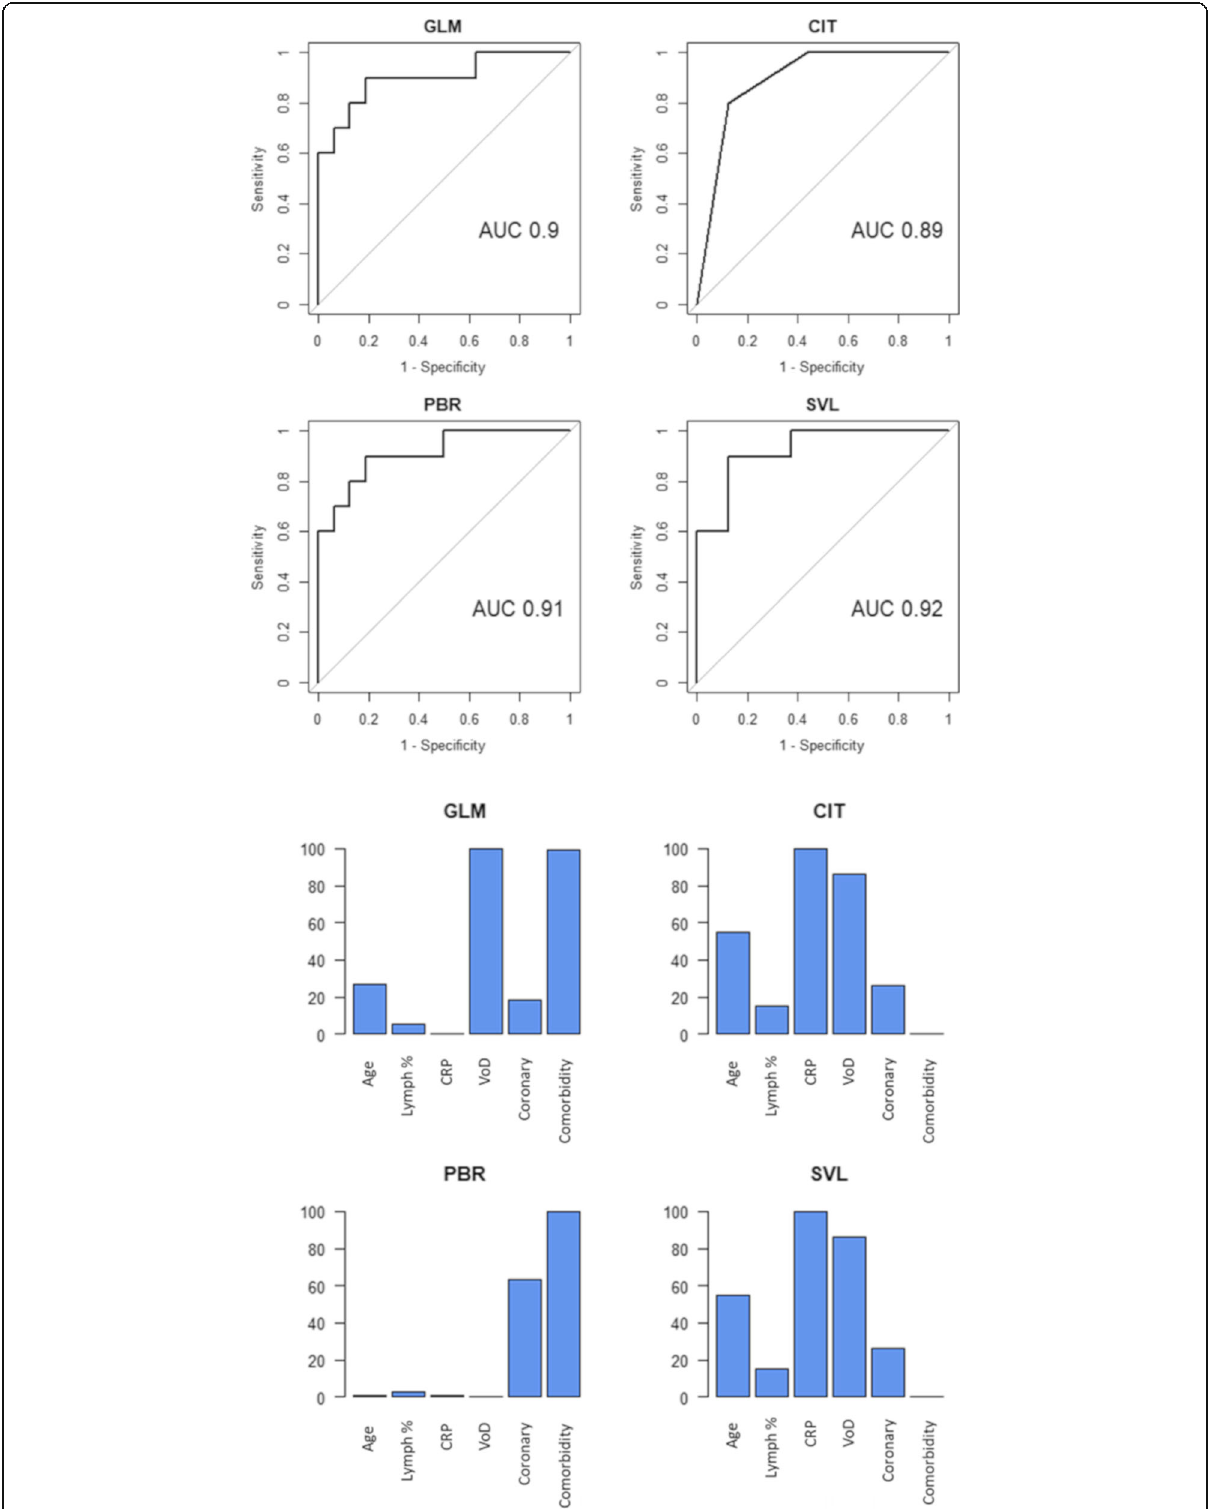
Fig. 5 Shows receiver operating characteristic curve analysis of each model and the corresponding variable importance. AUC, Area under the curve; CIT, Conditional inference trees; CRP, C-reactive protein; GLM, Generalised linear model; Lymph %, Lymphocyte percentage; PBR, Penalised binomial regression; SVL, Support vector machine with linear kernel; VoD, Volume of